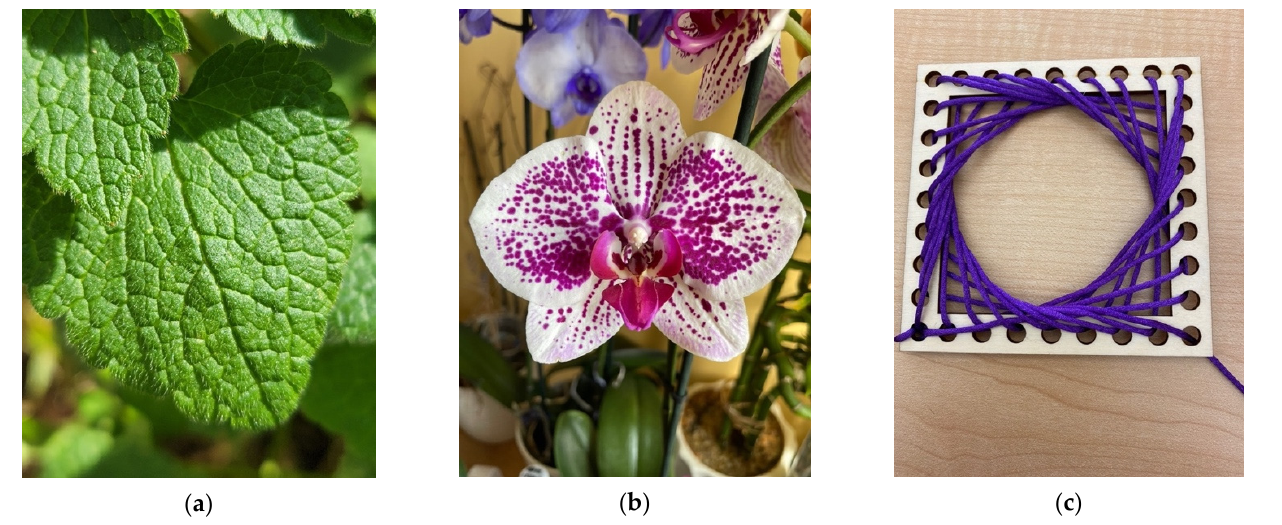
Figure 2. Participants’ photos: ( a ) James—Mint leaf, Voronoi pattern; ( b ) Chloe—Orchid petals, Fibonacci sequence (one lip, three inner petals, and five outside petals); ( c ) Mia—String art, circular pattern with two parabolas (conic section or two quadratic functions).